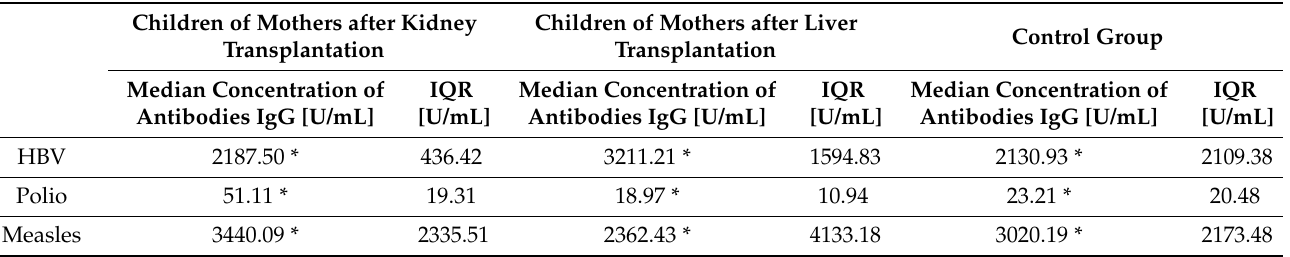
Table 6. Median and IQR of post-vaccination antibody concentrations (Anti-Poliomyelitis